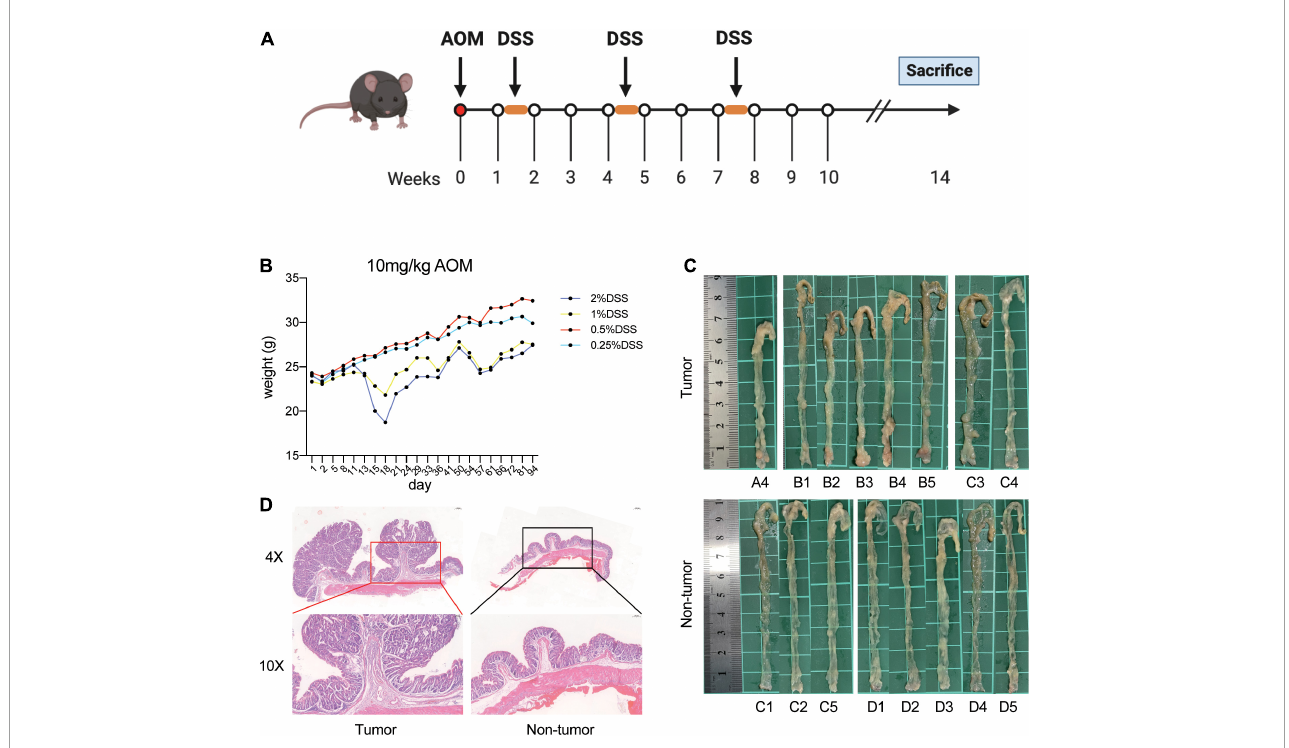
FIGURE1 Establishment of AOM/DSS-induced mice models. (A) Flow chart of the mice treated with AOM/DSS. (B) Weight of mice in each group during AOM/DSS treatment. (C) Macroscopic view of colon. (D) Representative hematoxylin and eosin stain of the distal colon with tumor and no